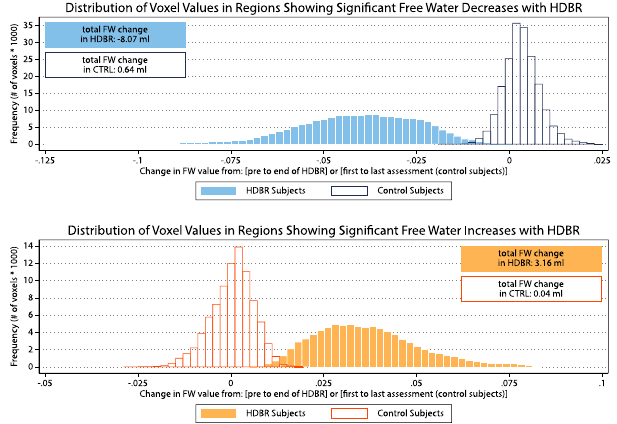
Figure 3. Magnitude of FW change with HDBR. The top graph shows the distribution of values of FW change for all voxels in the brain region in which the significant group-by-time interaction indicated a decrease in FW in HDBR (see Fig. 2A, blue regions). The bottom graph shows the distribution of values of FW change for all voxels in the brain region in which the significant group-by-time interaction indicated an increase in FW in HDBR (see Fig. 2A, red